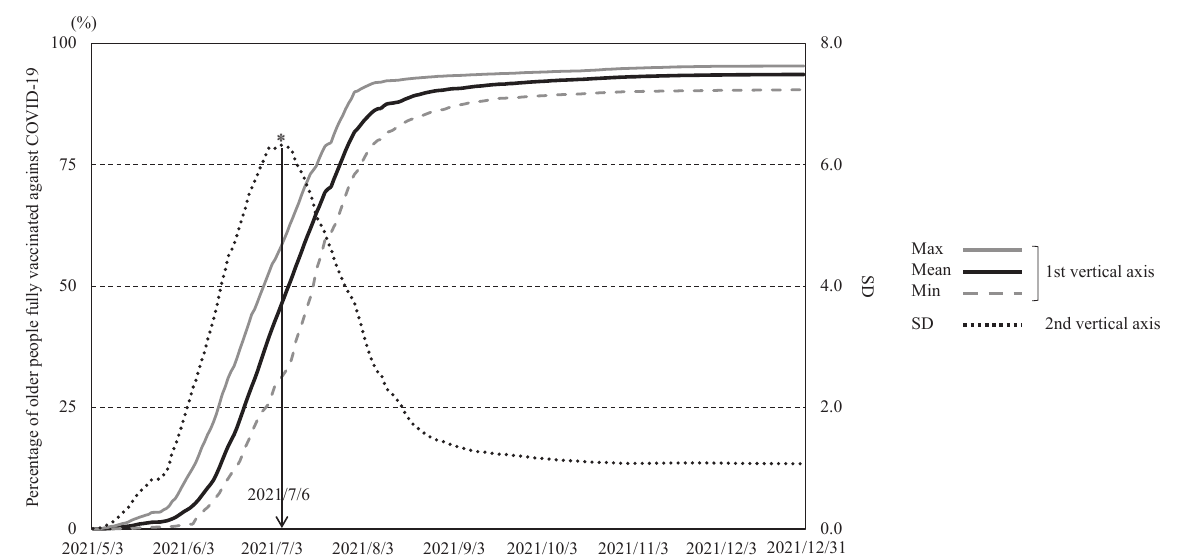
Fig. 1 Daily percentage of older people aged 65 and older fully vaccinated against COVID-19 from May 3, 2021 to December 31, 2021. SD: standard deviation of vaccination coverage across 47 prefectures. * : Time point with the largest standard